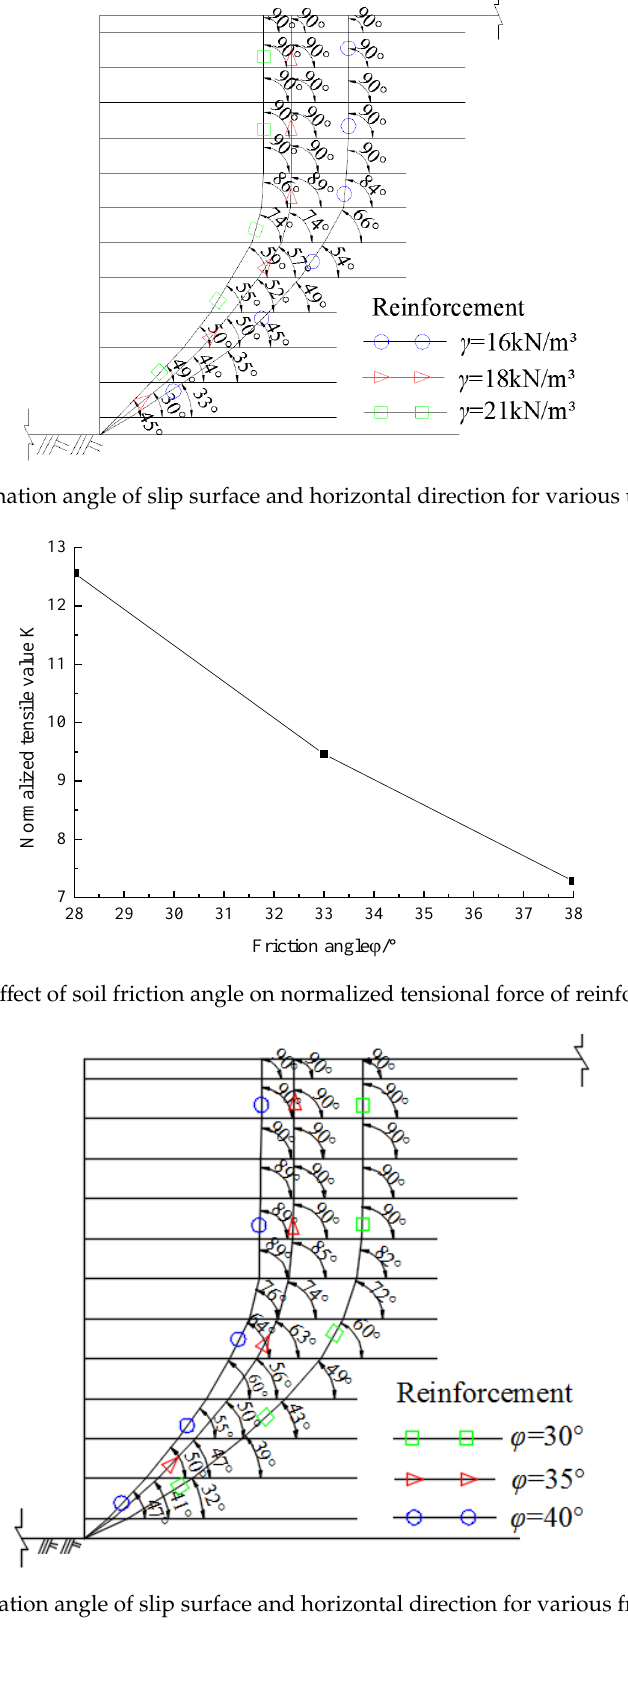
Figure 9. Effect of soil unit weight on normalized tensional force of reinforcement.